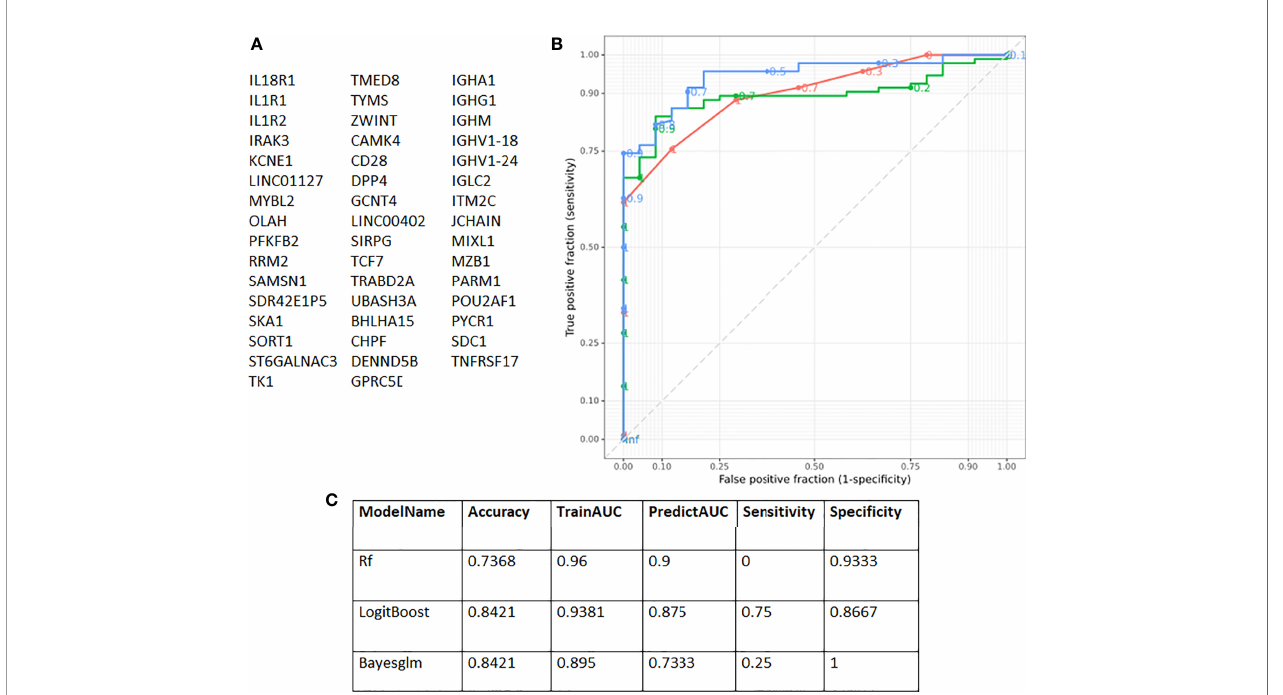
FIGURE 4 | Receiver Operating Characteristic (ROC) curves showing prediction accuracy COVID-19 survivors and non-survivors. (A) Genes identi fi ed with EdgeR and gene co-expression analysis and used for subsequent modelling. (B) ROC curves according to the three models used [Boosted Logistic Regression (LogitBoost), Bayesian Generalised Linear (Bayesglm) and RandomForest (rf)]. (C) In total three different models were used [RandomForest (rf), Boosted Logistic Regression (LogitBoost) and Bayesian Generalised Linear (Bayesglm)]. The 47 genes identi fi ed with gene co-expression and differential gene expression analysis were used as input. The highest sensitivity obtained was 75% and for speci fi city